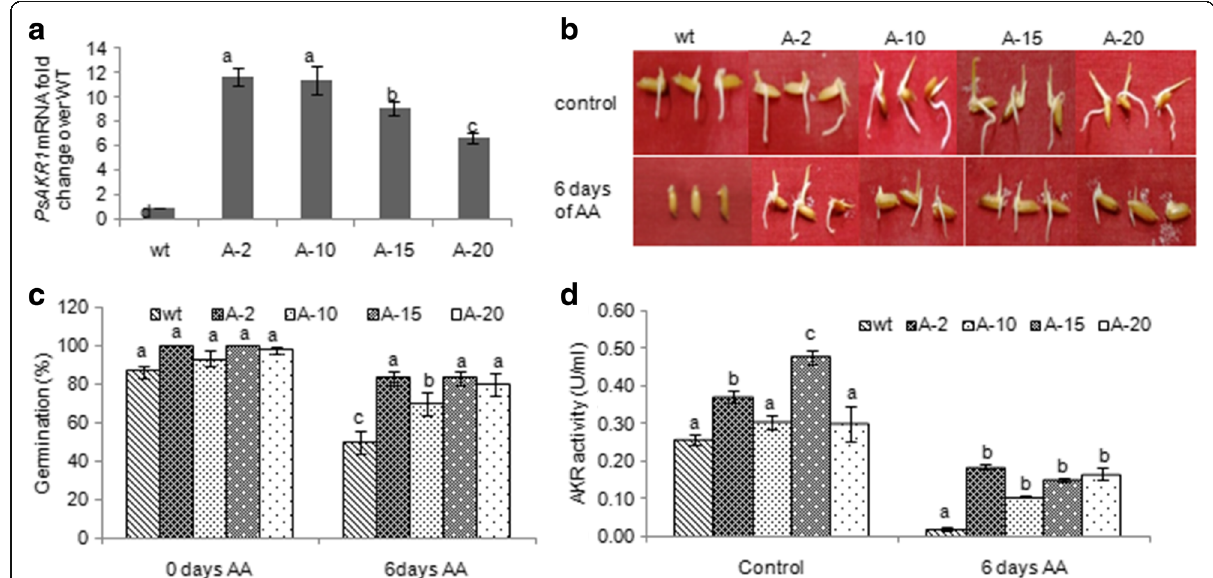
Fig. 4 Overexpression of PsAKR1 in susceptible rice genotype Tellahamsa showed improved seed viability and germination. a Transcript levels of PsAKR1 in different transgenic rice lines, The RNA from seeds were isolated and the cDNA is used as a template, b Photograph of transgenic rice seeds showing early germination after ageing treatment, c Germination percentage of transgenic seeds under 0 day and 6 days of AA is more compared to wild type Tellahamsa seeds, d AKR1 enzyme activity in rice seeds under control and ageing conditions. The total protein was extracted and enzyme activity was determined against Methylglyoxal as substrate. Minimum of three biological replicates were used in all the